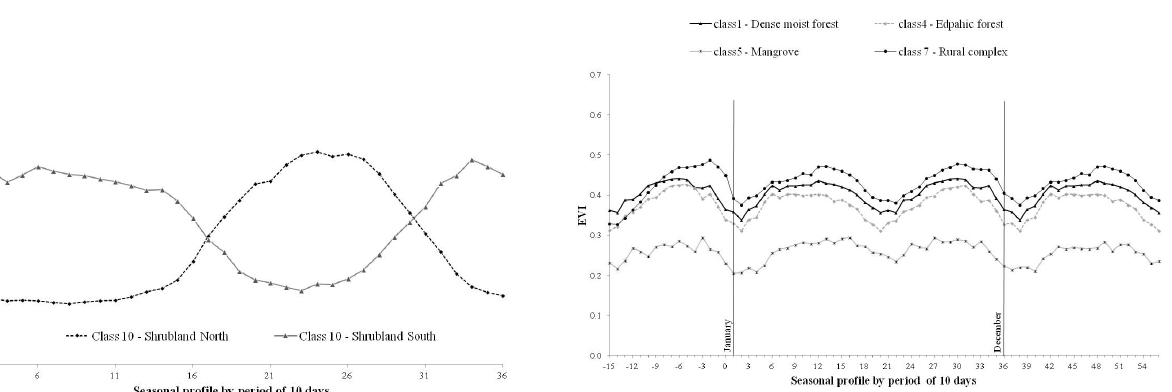
Fig. 4. January to December EVI temporal profile for class 10 – shrubland in the North and the South. This illustrates the inversion of seasonality between the North and the South.